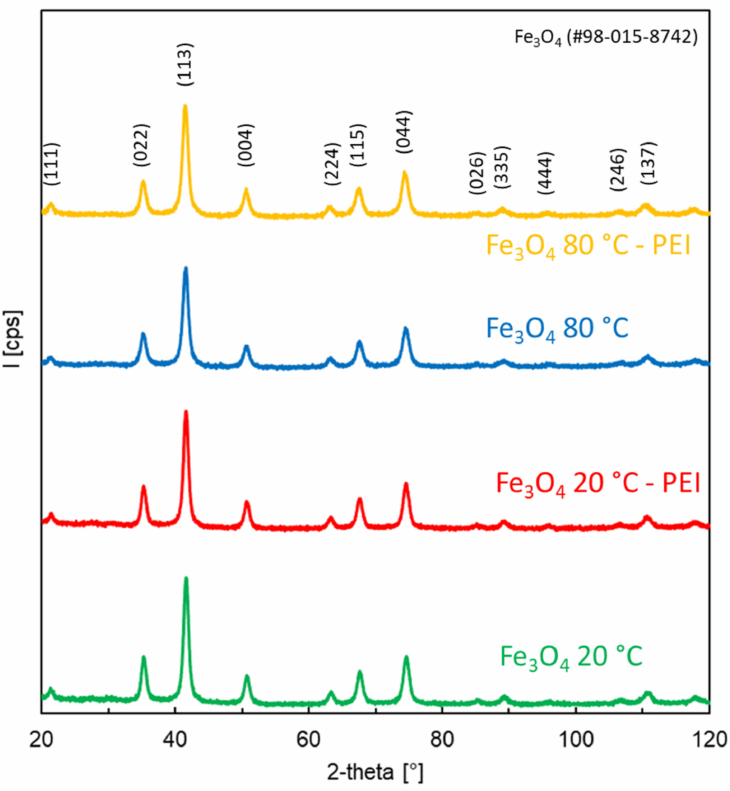
Figure 4. XRD patterns of Fe 3 O 4 NPs prepared at 20 and 80 ◦ C, and Fe 3 O 4 NPs prepared at 20 and 80 ◦ C and coated with